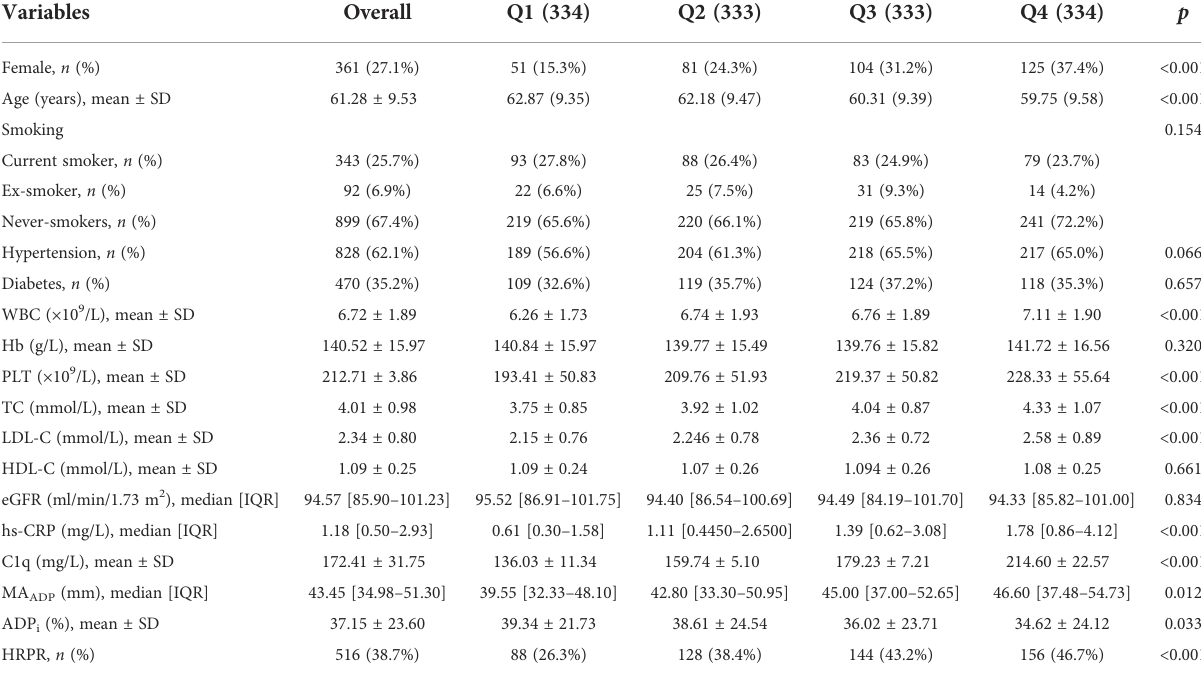
TABLE 2 Covariates of interest in patients with different C1q